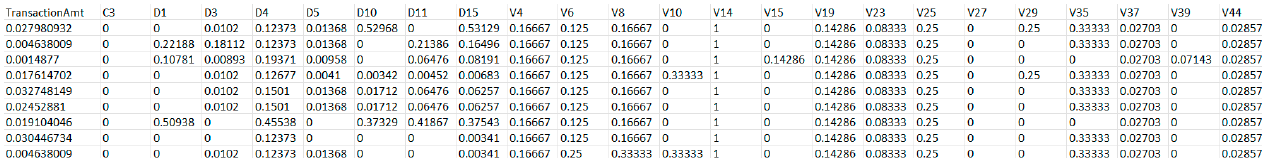
Figure 4. Correlation-based filter.